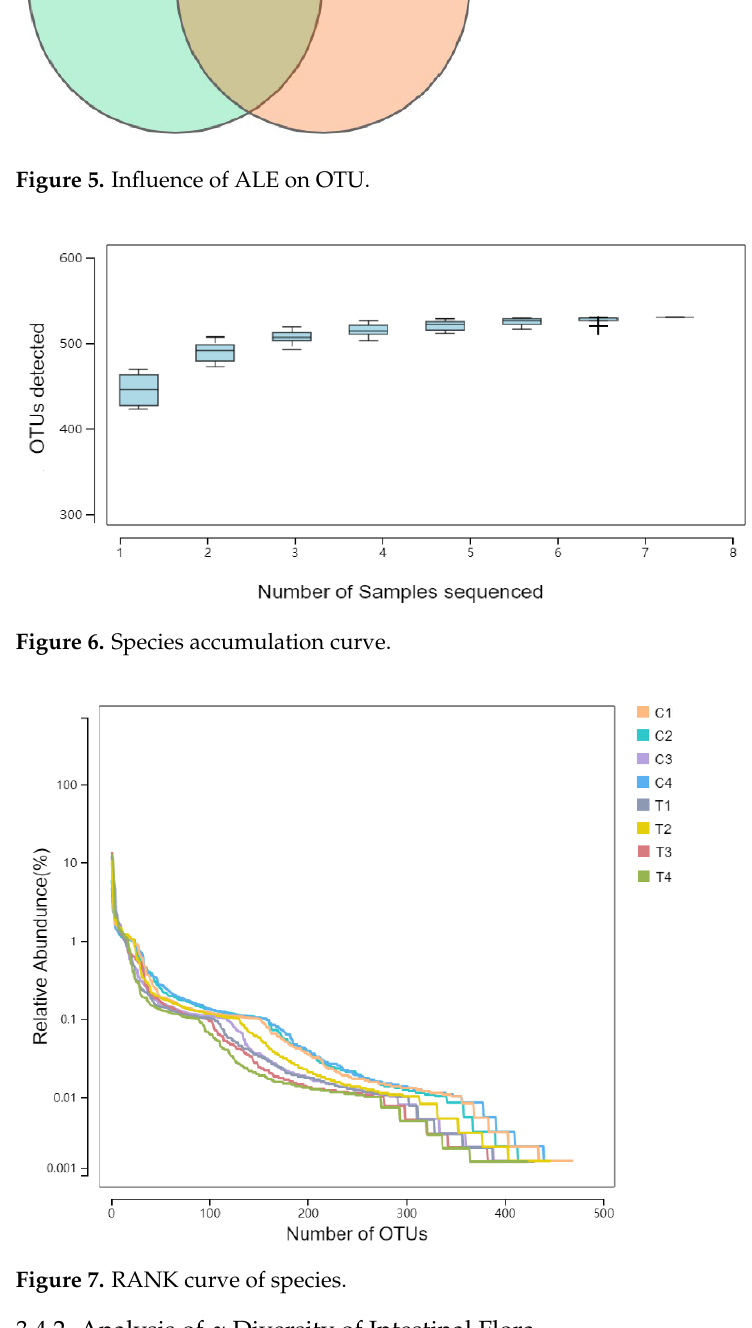
Figure 5. Influence of ALE on OUT.